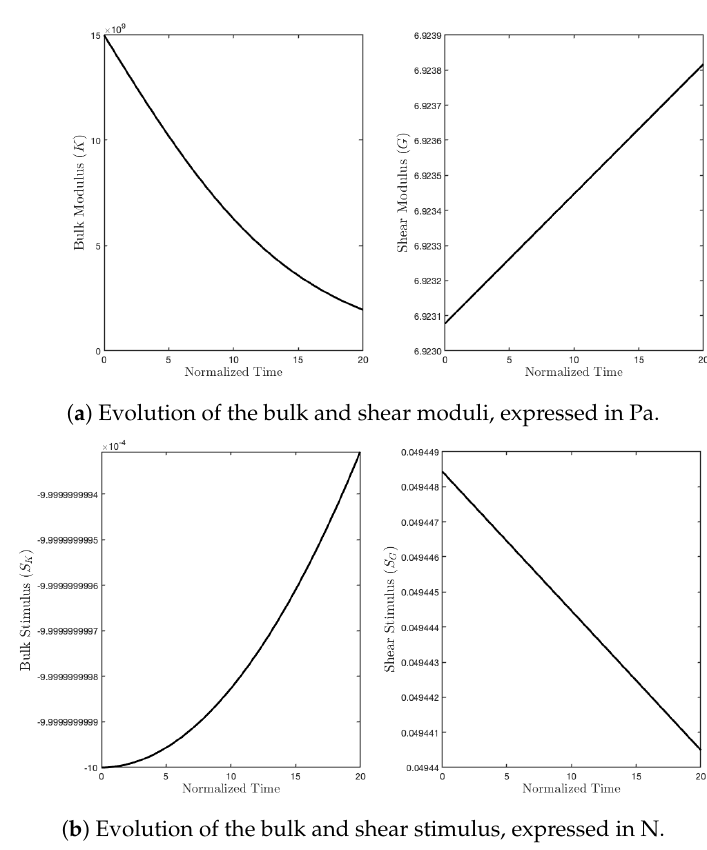
( b ) Evolution of the bulk and shear stimulus, expressed in N. Figure 8. Evolution of moduli and stimuli in time for the purely deviatoric